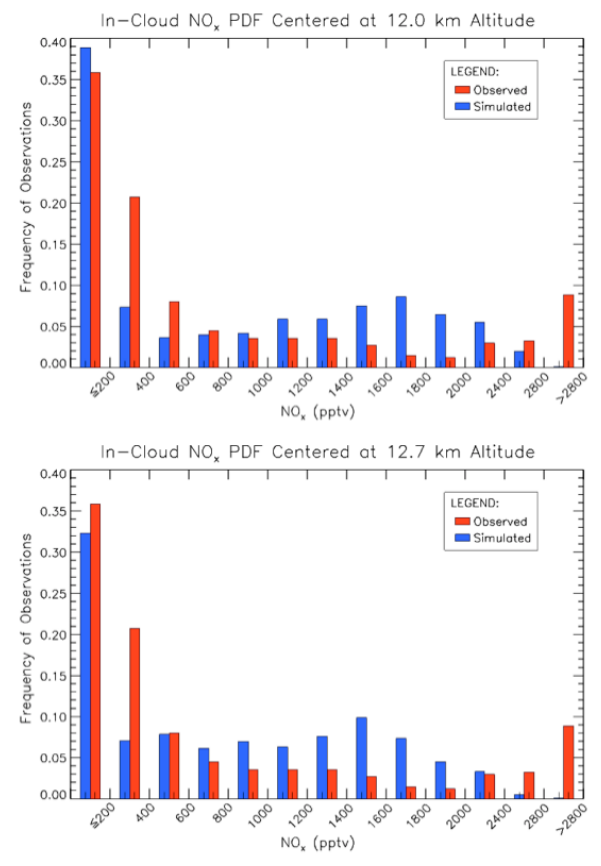
Fig. 15. PDF of NO x mixing ratios estimated from Egrett obser- vations (red) and simulated (blue) in the model layer centered at 12.0km and 12.7km given 500molesNOflash − 1 . The Egrett ob- served NO x includes the directly measured NO x between 13.2– 13.8km and that estimated from the photostationary state when only one of NO or NO 2 were available.